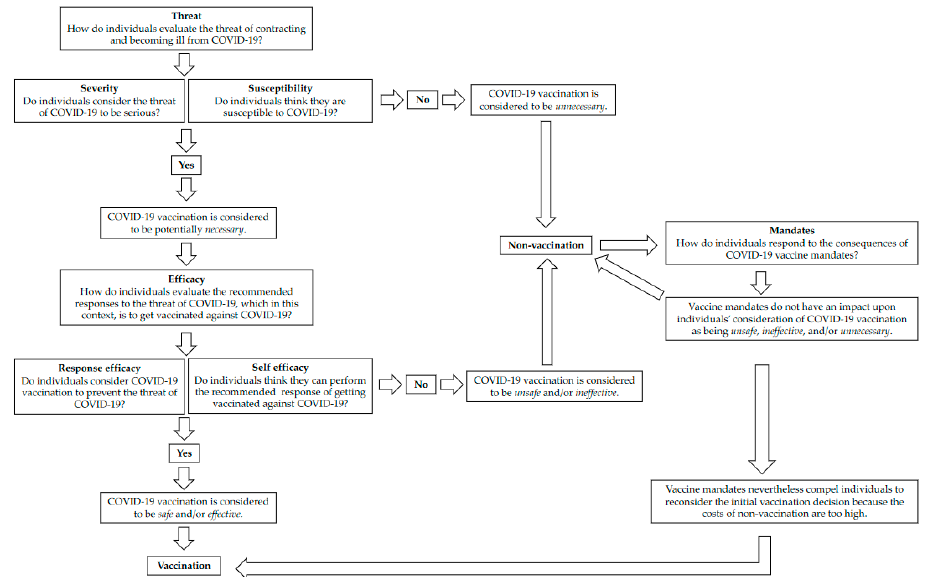
Figure 3. Patient journey and resulting in becoming